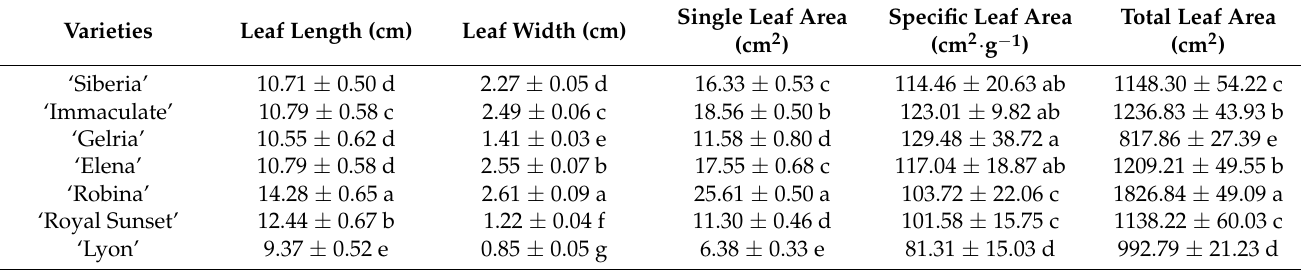
Figure 2. Leaf morphology of seven lily varieties. Table 2. Leaf characteristics of seven lily